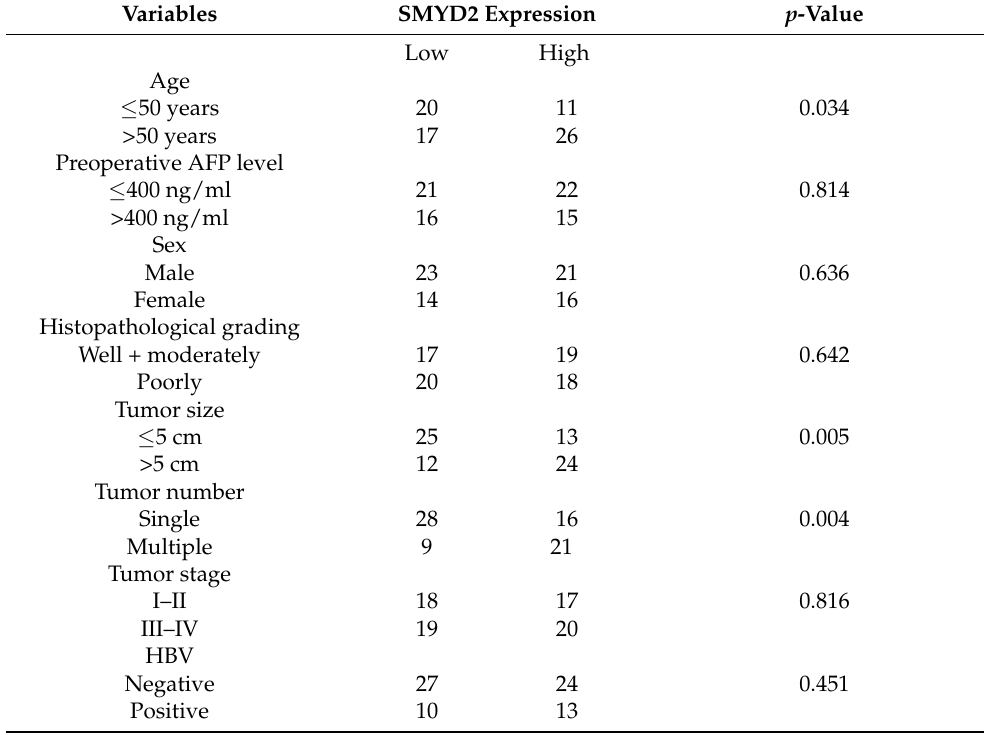
Figure 1. SMYD2 is overexpressed in HCC and is associated with unfavorable prognosis. ( A ) The expression level of SMYD2 in 80 HCC specimens and paired adjacent liver specimens was examined by RT-qPCR. ** p < 0.01. ( B ) The expression of SMYD2 in TCGA datasets. *** p < 0.001.( C ) The mRNA level of SMYD2 in seven HCC cell lines and LO2. ( D ) The Protein level of SMYD2 in seven HCC cell lines and LO2. ( E ) Kaplan – Meier analysis of overall survival time of HCC patients based on SMYD2 expression ( n = 74). Table 1. Correlation between SMYD2 expression and clinicopathological features in HCC